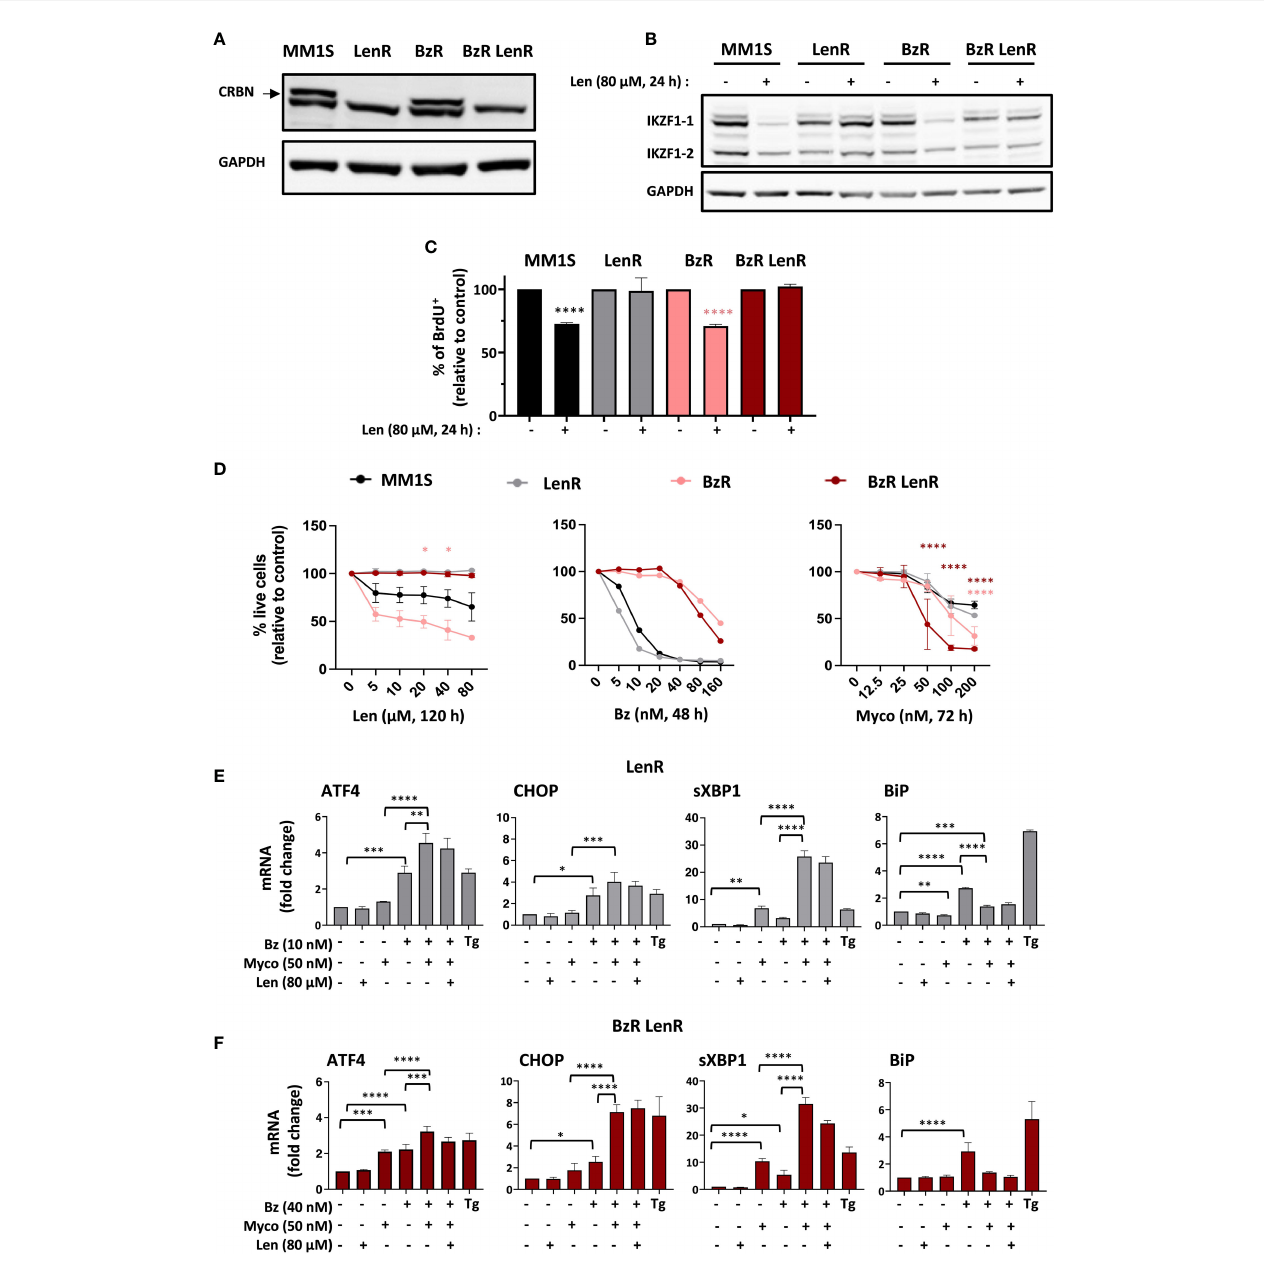
FIGURE 1 Sec61 blockade overrides MM resistance to Len. (A) Expression of CRBN by MM1S (parental) and BzR, LenR, BzR LenR daughters. (B) Expression of IKZF1.1/2 in the 4 cell lines treated with 80 µM Len or vehicle for 24h. In (A, B) , protein levels were assessed in cell lysates and quanti fi ed relatively to GADPH levels. (C) Proportion of proliferating cells, as assessed by BrdU incorporation, in the 4 cell lines treated as in (B) . Data are Mean % ± SD of technical triplicates relative to vehicle controls, from one experiment representative of two. (D) Comparative analysis of drug susceptibility of the four cell lines. Each cell line was treated with Len (120h), Bz (48h) or Myco (72h), and cell viability was assessed by exposure of Annexin V and incorporation of PI. Data are Mean % of live cells (relative to controls) from the cumulated results of 3 (Len), or 2 independent experiments (Bz and Myco). Differences between daughter cell lines and parental MM1S by one-way Anova followed by Tukey ’ s multiple comparison test (*p<0.05, ****p<0.0001). (E) In LenR MM1S cells treated as indicated with the different drugs or vehicle for 6h, mRNA levels of ATFA, CHOP, sXBP1 and BiP were quanti fi ed by qPCR. Thapsigargin (Tg, 2 µM, 6 h) was used as positive control. Shown mRNA data are Mean fold changes (2 - DD CT ) ± SD, relative to untreated controls from the cumulated data of 3 independent experiments. (F) Same as (E) with BzR LenR MM1S cells. In (C) , (E, F) , differences between treated cells and controls by two-way Anova followed by Tukey ’ s multiple comparison test (*p < 0.05; **p < 0.01; ***p < 0.001, ****p <